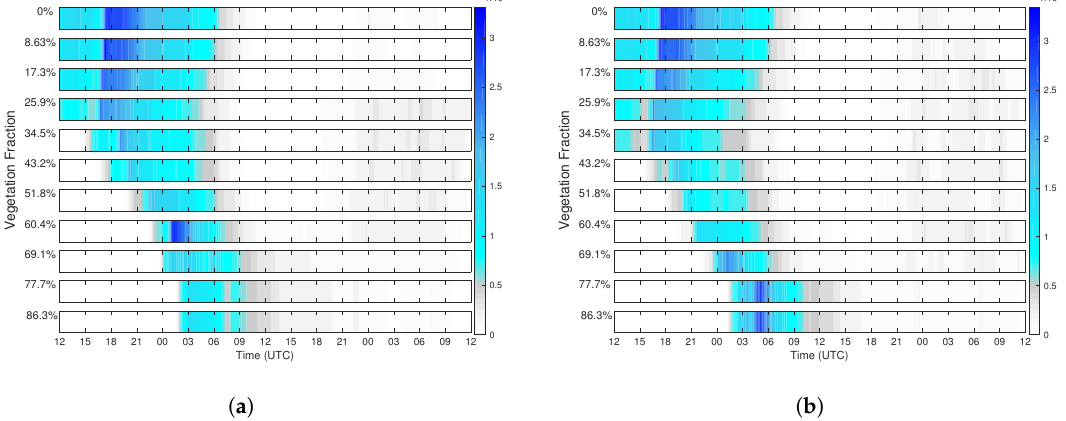
Figure 11. Time steps for the single- ( a ) and multilayer ( b ) SBL schemes in which active icing occurred during the 18 October 2014 case for each vegetation cover fraction. Colors indicate the icing intensity